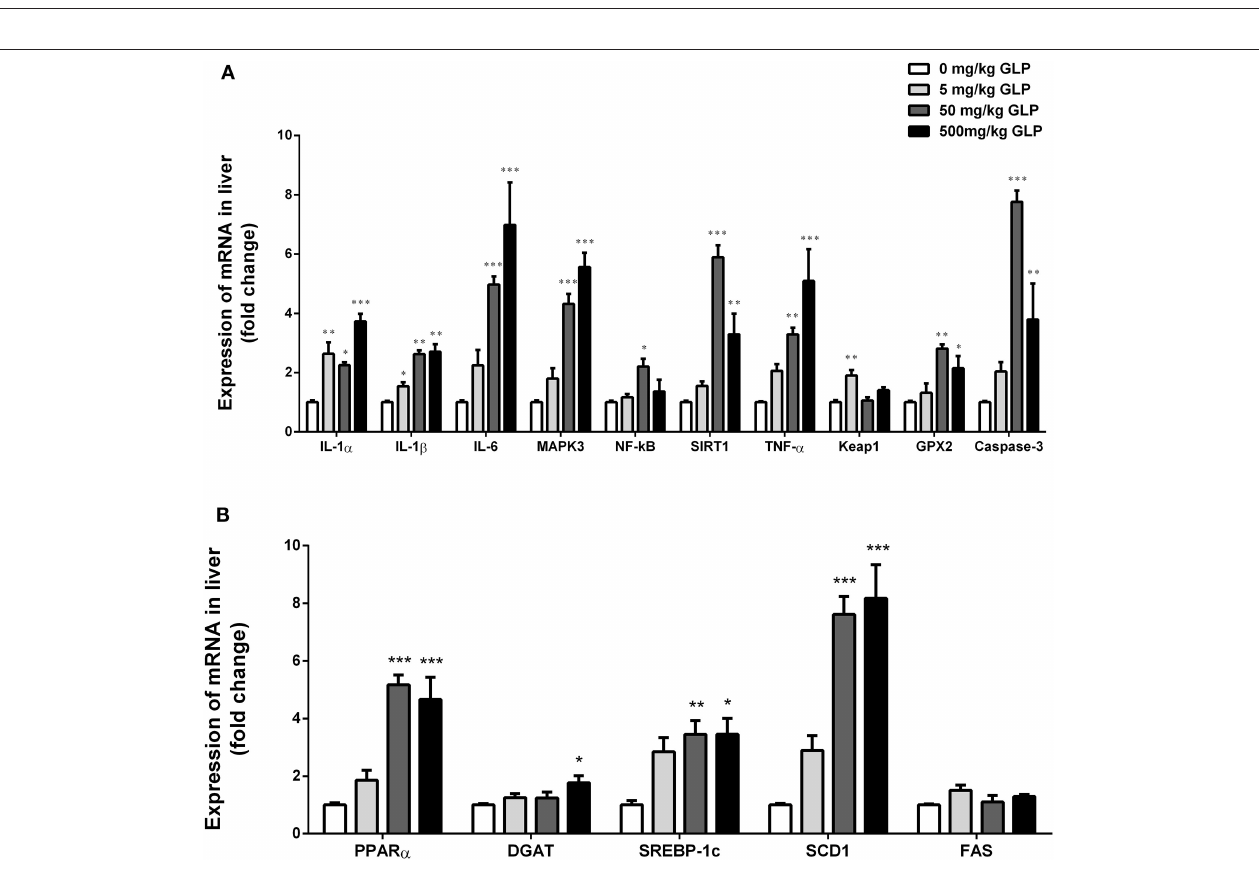
FIGURE 4 | Real-time RT-PCR analyses of IL-1 α , IL-1 β , IL-6, MAPK3, NF-kB, SIRT1, TNF- α , Keap1, GPX2, and Caspase-3 mRNA of liver (A) . Real-time RT-PCR analyses of PPAR α , DGAT, SREBP1c, SCD1, and FAS mRNA of liver (B) . Data shown are mean ± SEM of eight animals in each group. Compared to control; * p < 0.05, ** p < 0.01 and *** p < 0.001.